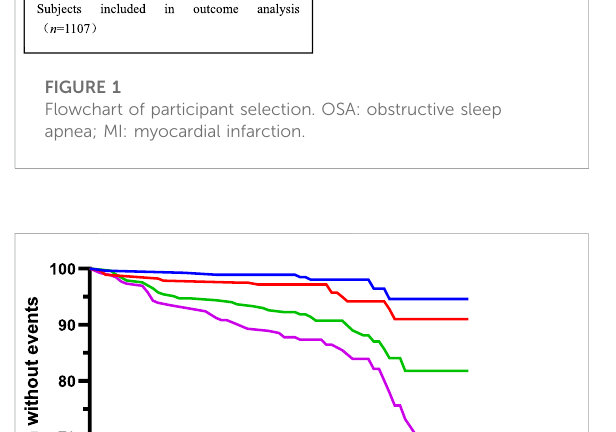
FIGURE 3 Kaplan – Meier curves for MACE according to median